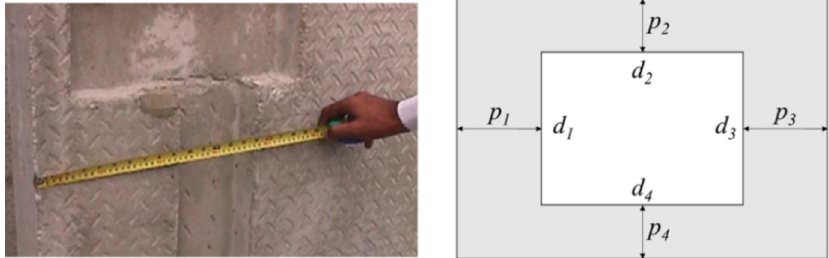
Figure 4. Measurement of the dimensions ( d 1 to d 4 ) and positions ( p 1 to p 4 ) of an opening on a structural element.